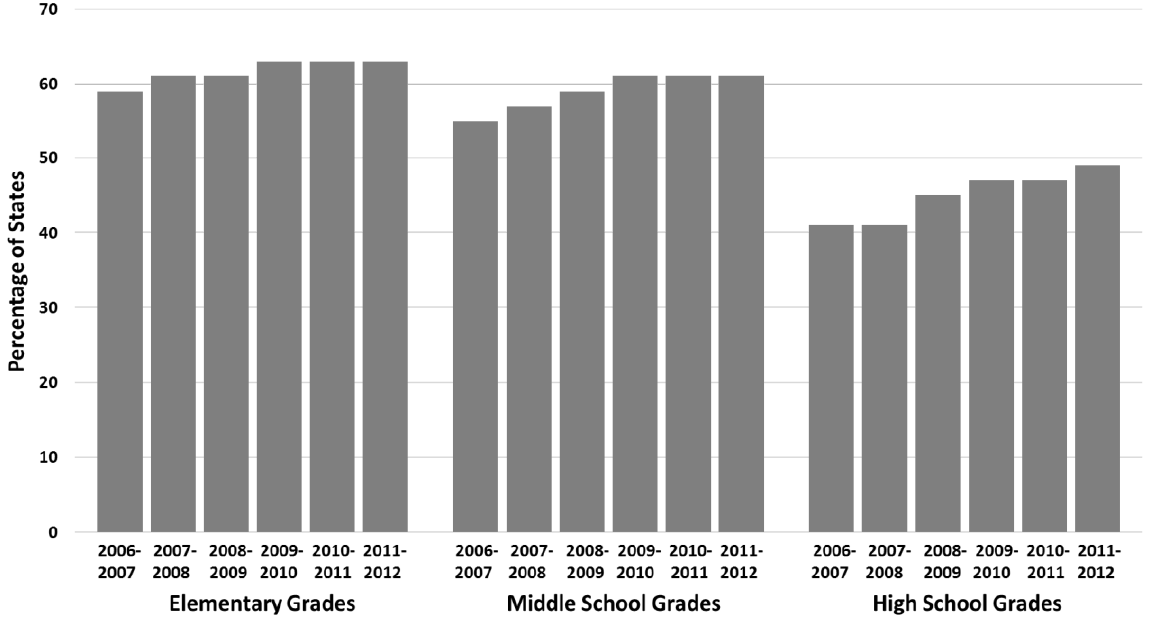
Source: Adapted from data found in Institute of Medicine, 2013.